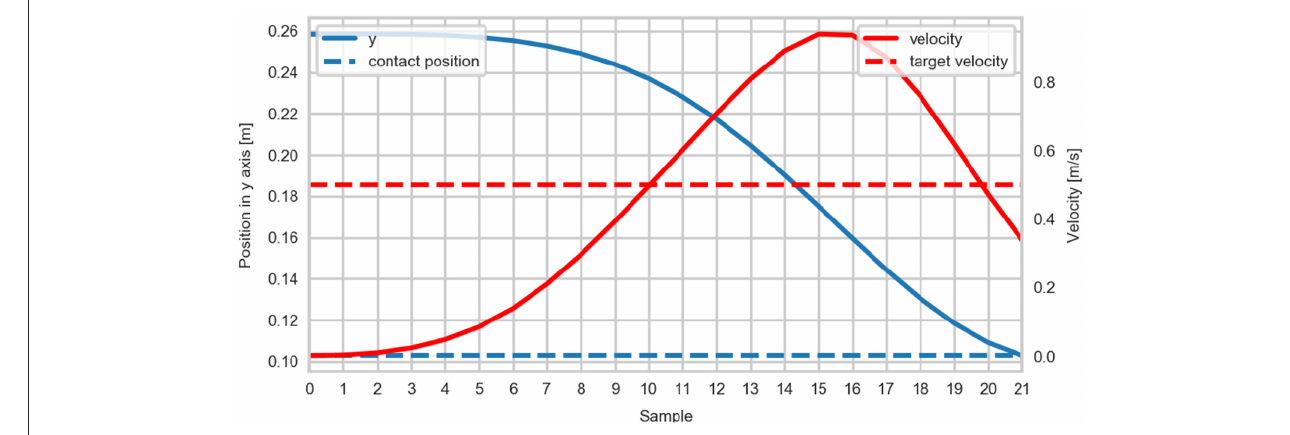
FIGURE 3 | Representative vertical position and velocity curves during a trial.